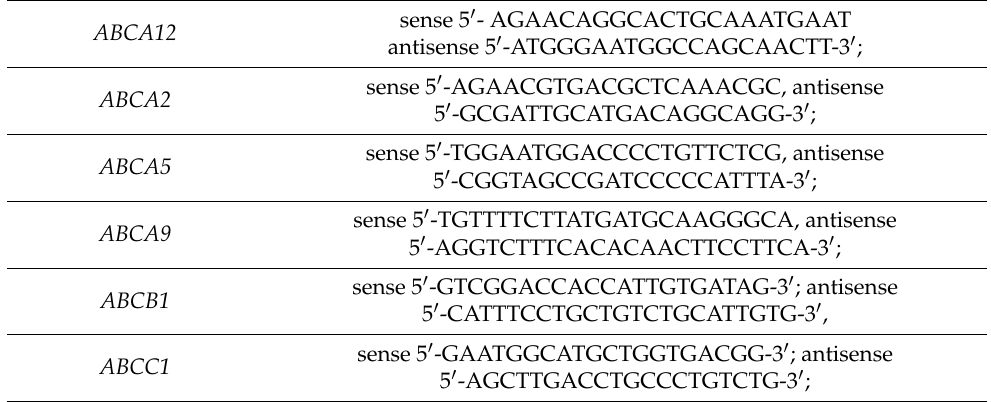
Table 2. Sequences of the primers used in this